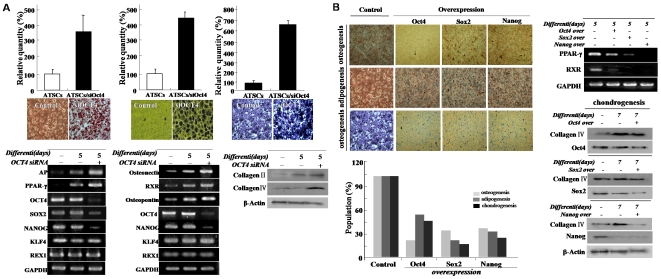
Effect of exogenic Oct4 and several stemness gene expressions on adipogenic, osteogenic, and chondrogenic differentiation potencies.(A) Oct4 knockdown actively induces adipogenic, osteogenic, and chondrogenic differentiation. Differentiation potency was evaluated by fat, bone, and chondrocyte staining and lineage specific gene expression pattern by RT-PCR or western blotting using tissue specific markers. (B) Exogenic stemness genes expression affect on mesodermal differentiation potency. After differentiation induction of Oct4/ATSCs and control ATSCs, the number of positive clones was quantified after fat (Oil Red O), bone (Van Kossa), and chondrocyte staining (Van Gieson) and data presented relative density of positive population (%). (C) Effect of stemness genes overexpression on differentiation of ATSCs into bone, fat, and chondrocyte and their lineage specific gene expression analysis after differentiation induction.